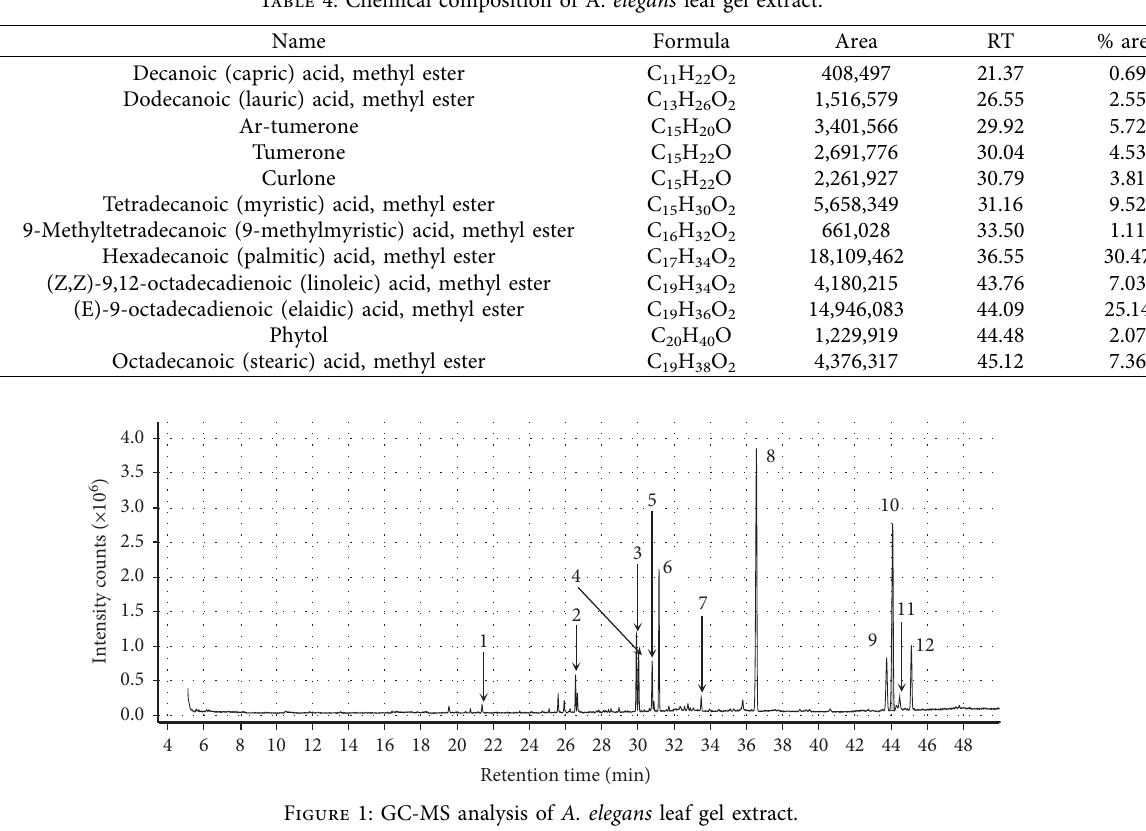
Table 4: Chemical composition of A. elegans leaf gel extract.